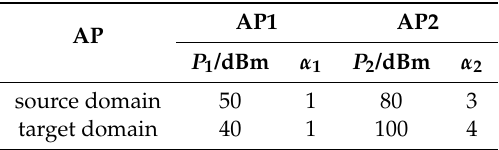
Table 1. Channel model parameters change in